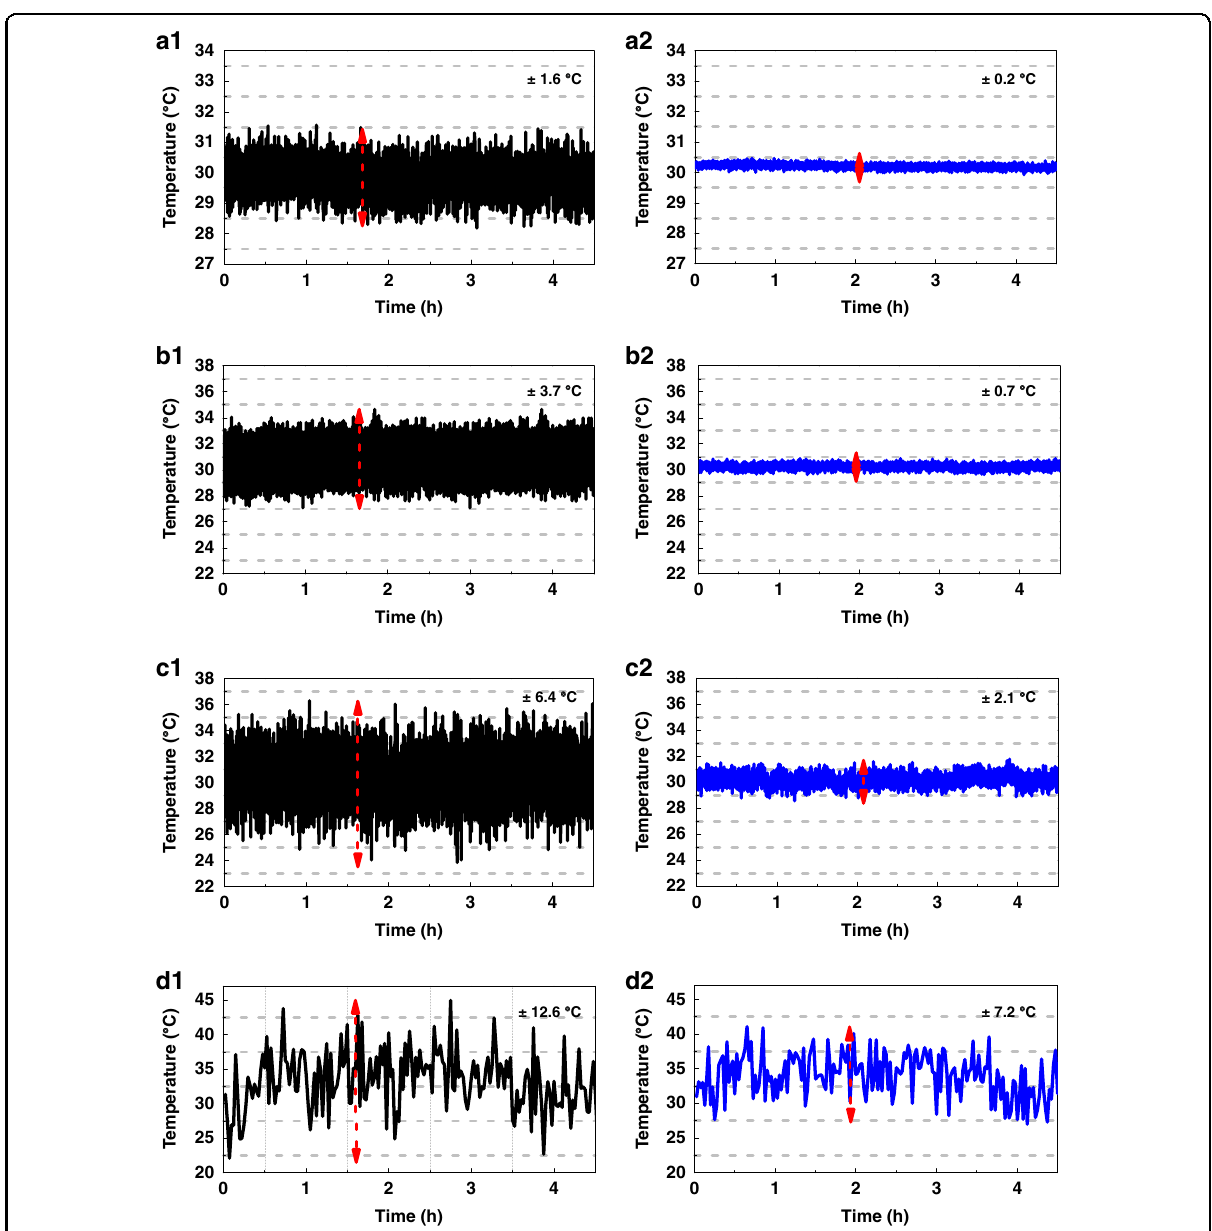
Fig. 7 Measurement temperature stability at different sensing distances. Experimental results using the conventional demodulation scheme at ( a1 ) 1.38 km, ( b1 )10.22 km, ( c1 )18.80 km, and ( d1 ) 28.90 km. Experimental results at ( a2 ) 1.38 km, ( b2 ) 10.22 km, ( c2 )18.80 km, and ( d2 ) 28.90km using the auto-correction scheme. Reprinted with permission from ref. 116 , © The Optical